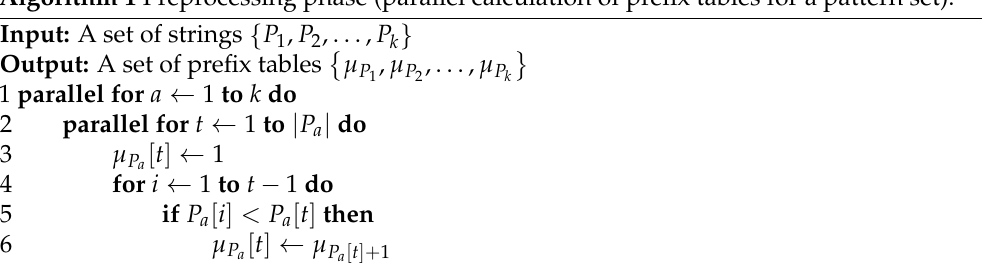
Algorithm 1 Preprocessing phase (parallel calculation of prefix tables for a pattern